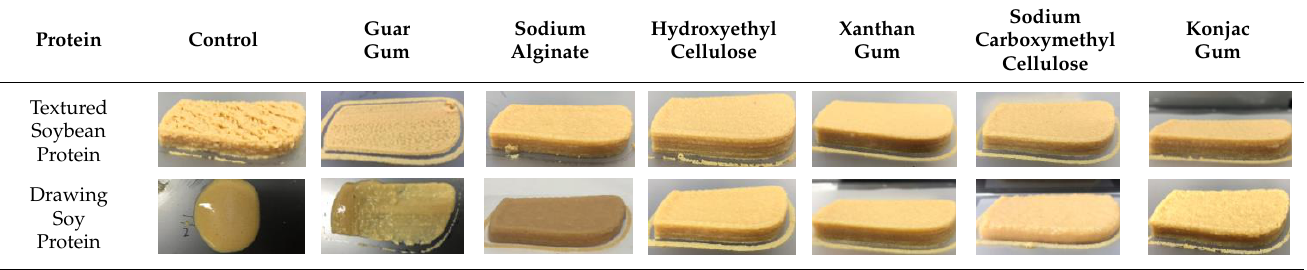
Table 3. Printing results of different protein and hydrocolloid composite ink systems.